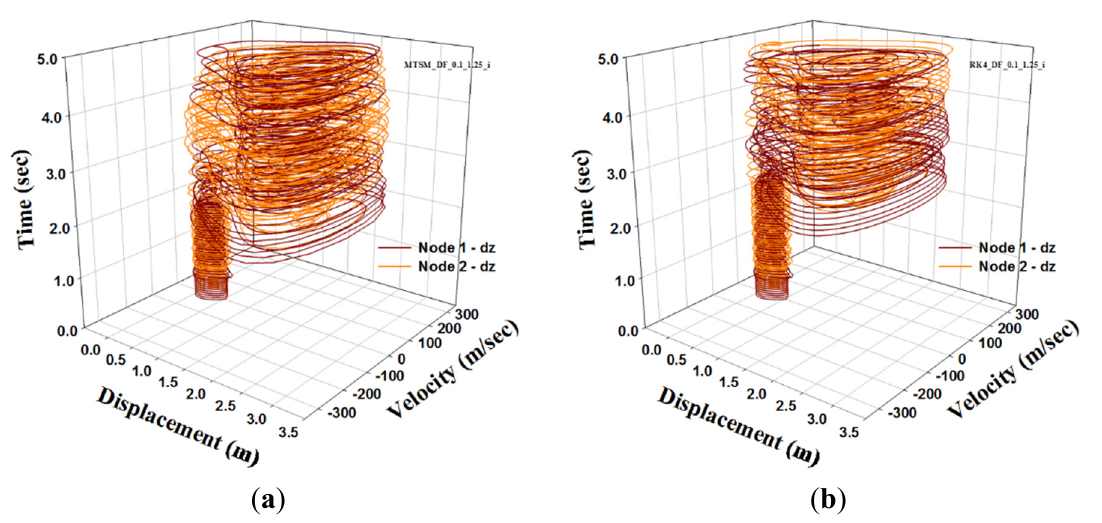
Figure 12. Phase diagram of DFN model. (Imperfect case): ( a ) TSM; ( b )